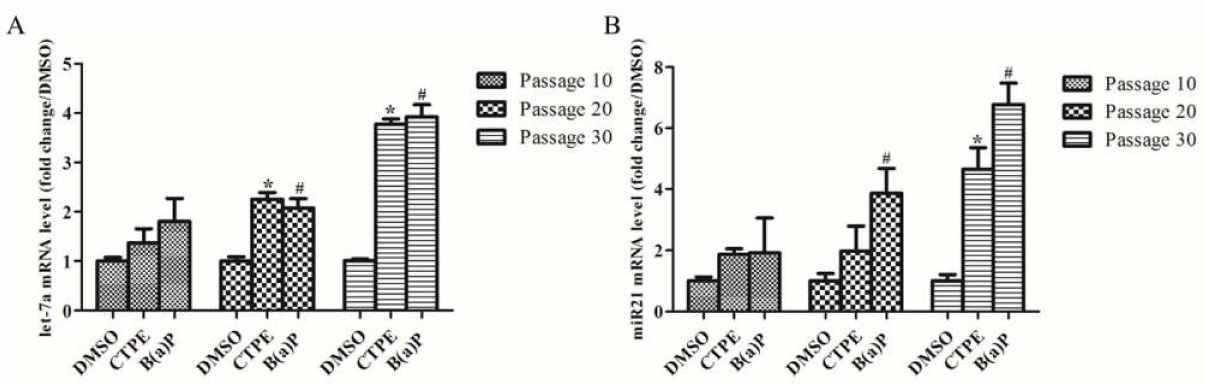
Figure 5. let-7a and miR-21 levels in cells at passage 10, 20, and 30 among three groups. The levels of ( A ) let-7a and ( B ) miR-21 in DMSO, CTPE, and B(a)P groups at passage 10, 20, and 30. The results were presented as mean ± SD ( n = 3, *: CTPE vs. DMSO, p < 0.05. #: B(a)P vs. DMSO, p